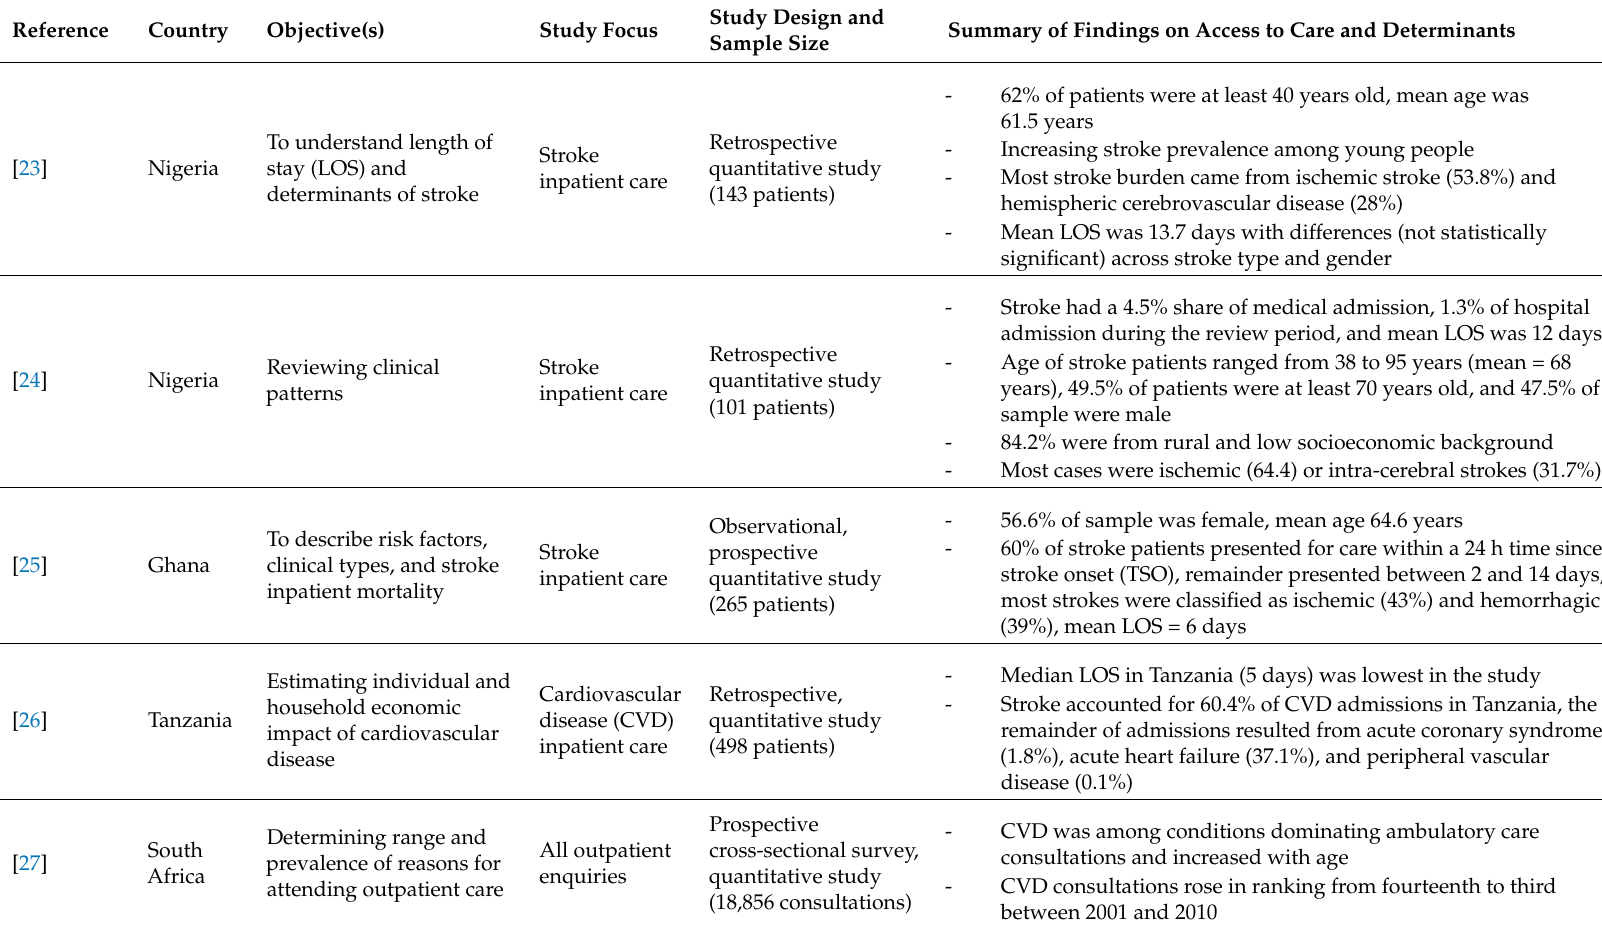
Table 1. Summary of reviewed